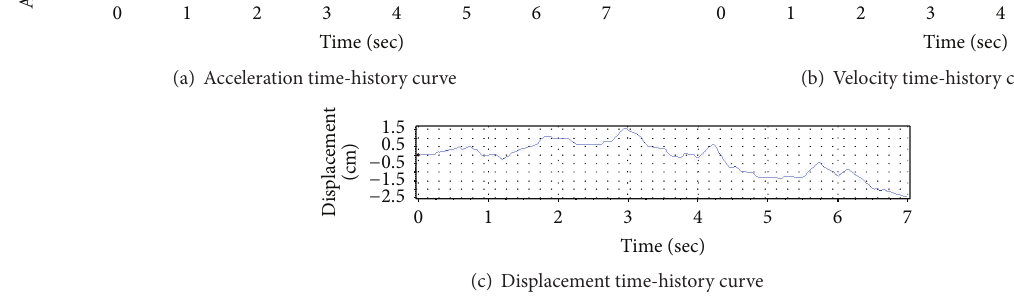
Figure 8: Original seismic wave time-history curve.